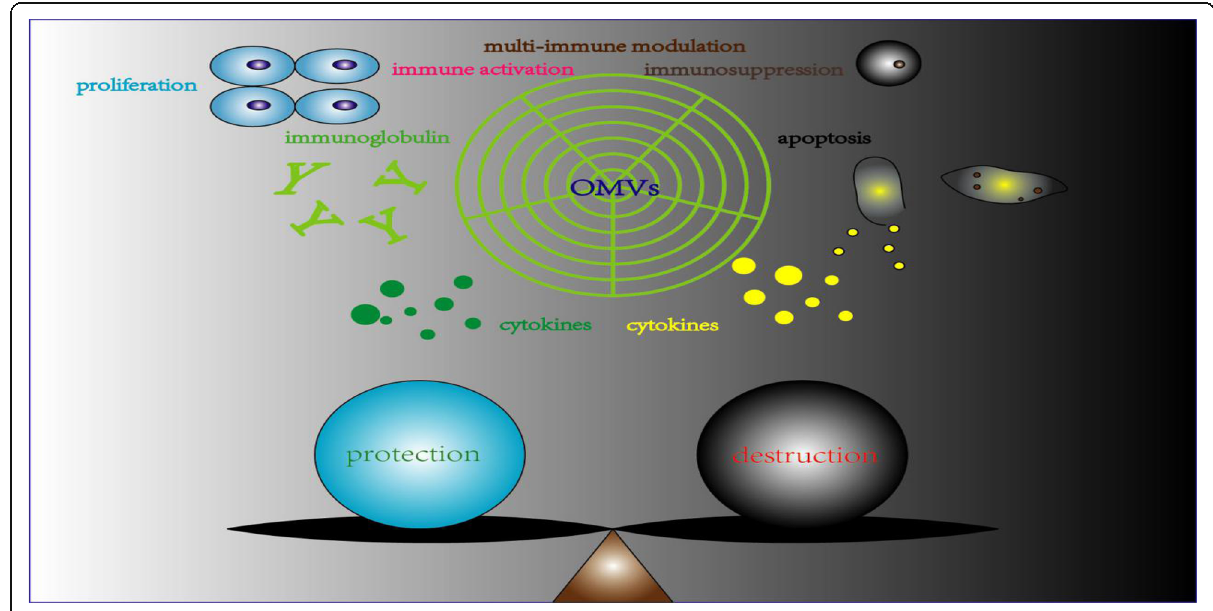
Fig. 3 Double-edged effects of OMVs in host. Legend section: protection; destruction; proliferation; immunoglobulin; cytokines; immune activation; immunosuppression;